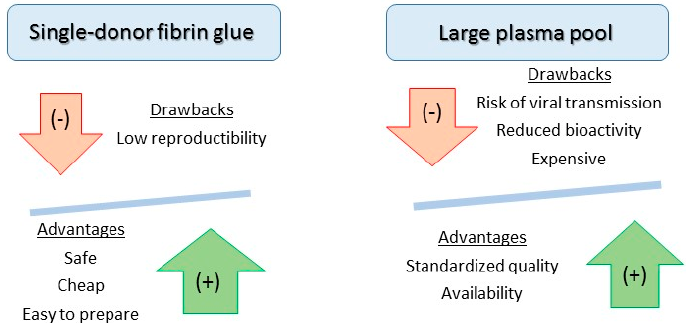
Figure 3. Main advantages and drawbacks according to the origin of fibrin glue.